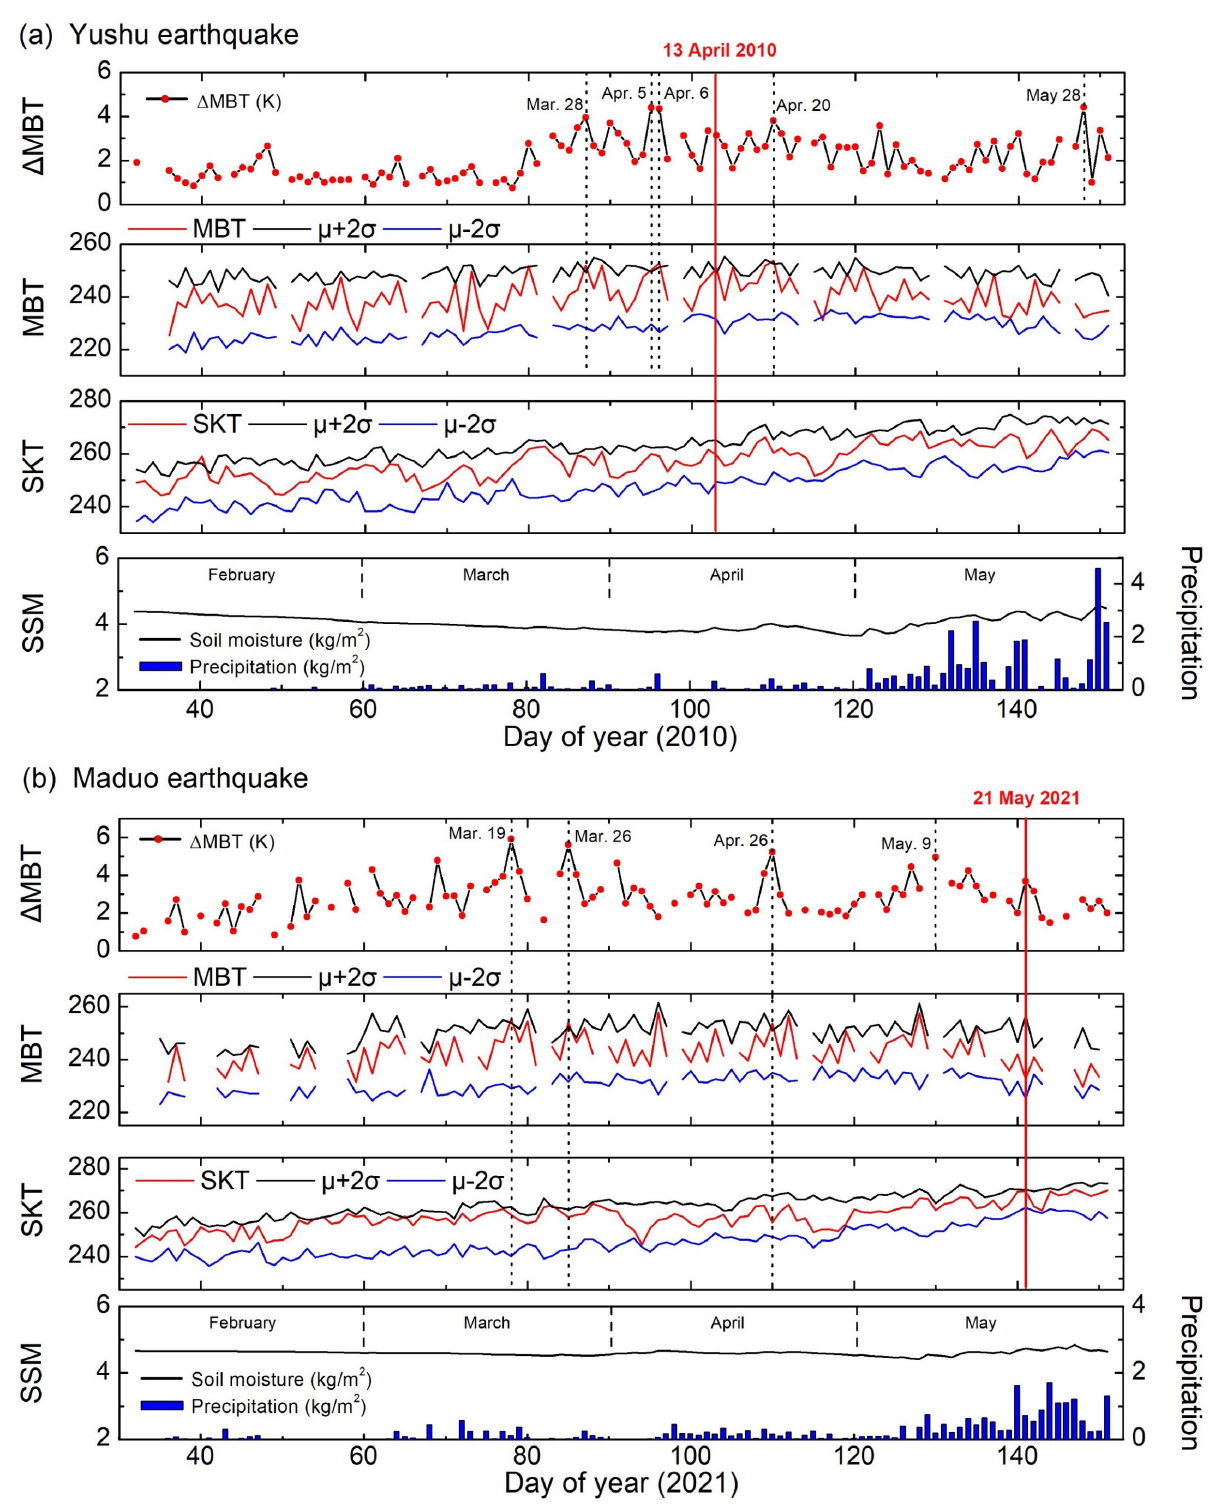
Figure 9. Variations of averaged MBT together with its anomalies, SKT, SSM, and precipitation within Bayan Har block before and after the Yushu EQ ( a ) and the Maduo EQ ( b ). According to microwave remote sensing physics, the microwave radiation of the ground surface depends largely on surface temperature and microwave dielectric properties. In Figure 9, the curves of averaged MBT and SKT exhibited the multi-year stable state of microwave radiation and surface temperature within the Bayan Har block ( µ ),